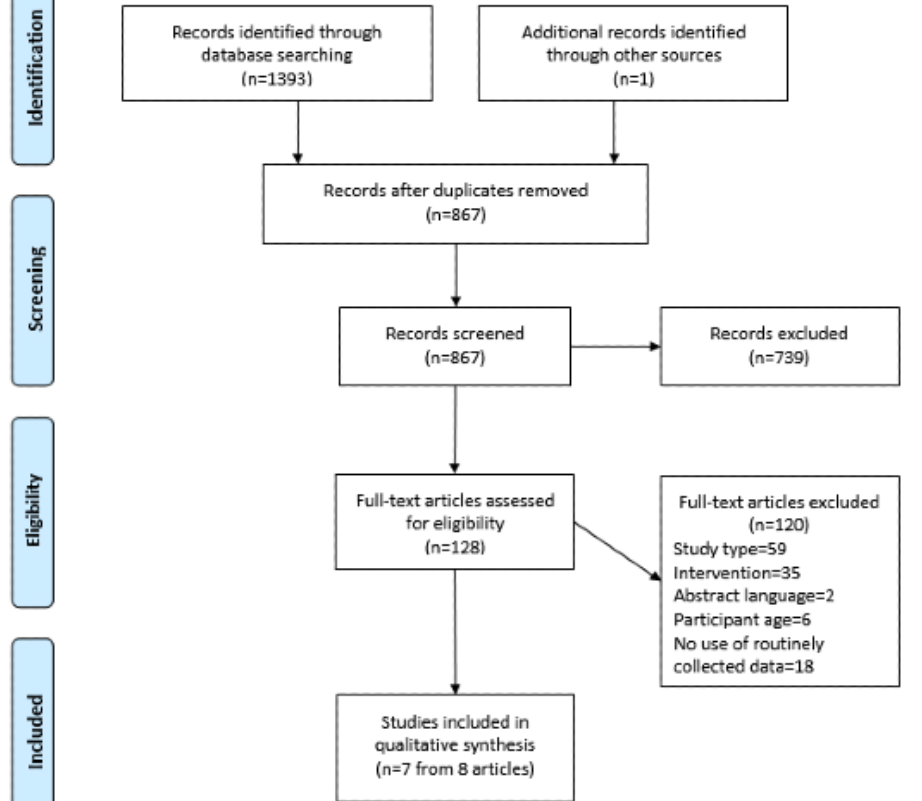
Figure 2. PRISMA (Preferred Reporting Items for Systematic Reviews and Meta-analyses) flow